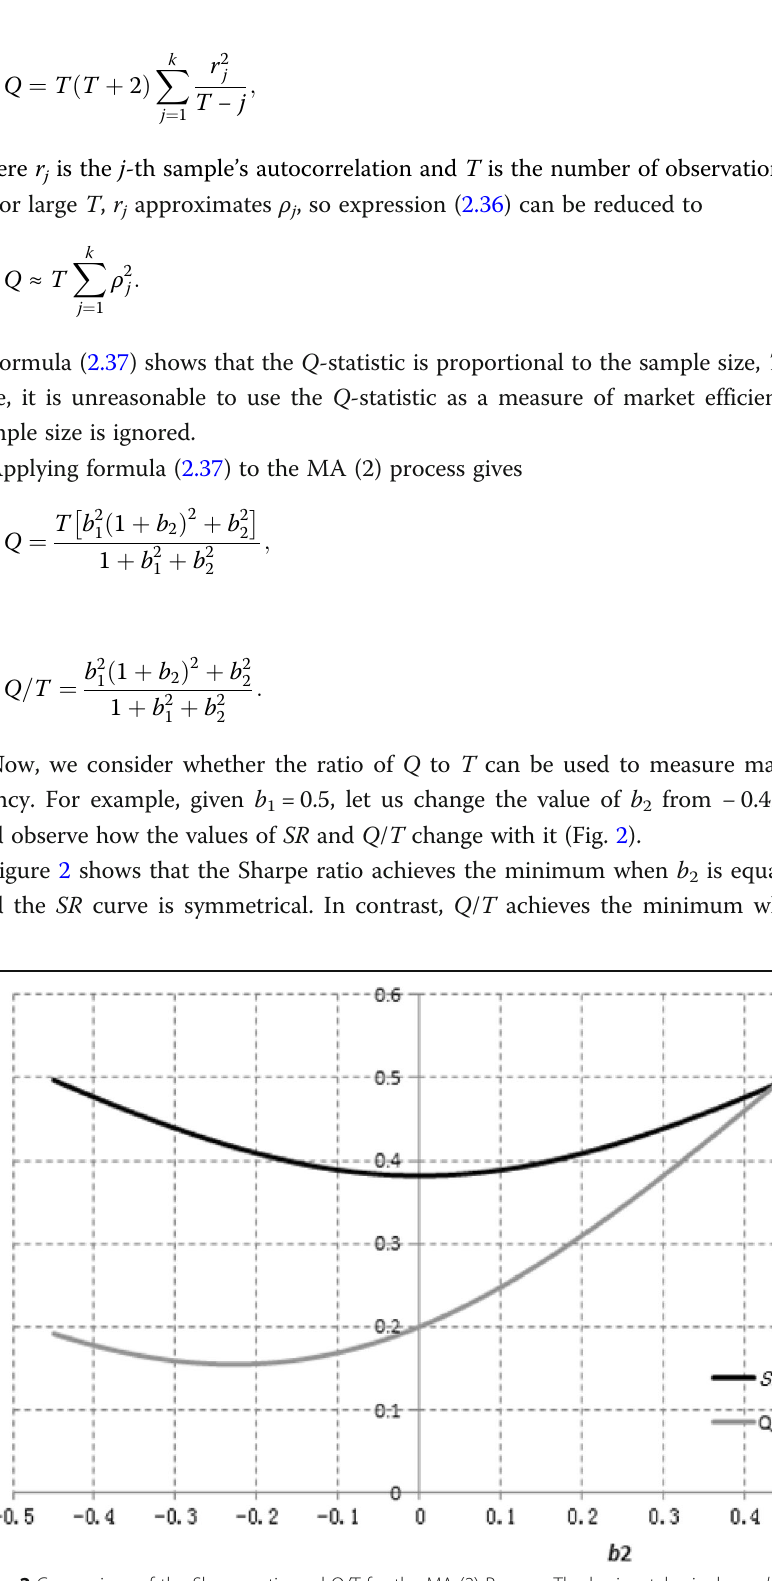
Fig. 2 Comparison of the Sharpe ratio and Q/T for the MA (2) Process. The horizontal axis shows b 2 , the coefficient of the second moving average term. The vertical axis shows the Sharpe ratio or the ratio of the Q -statistic to sample